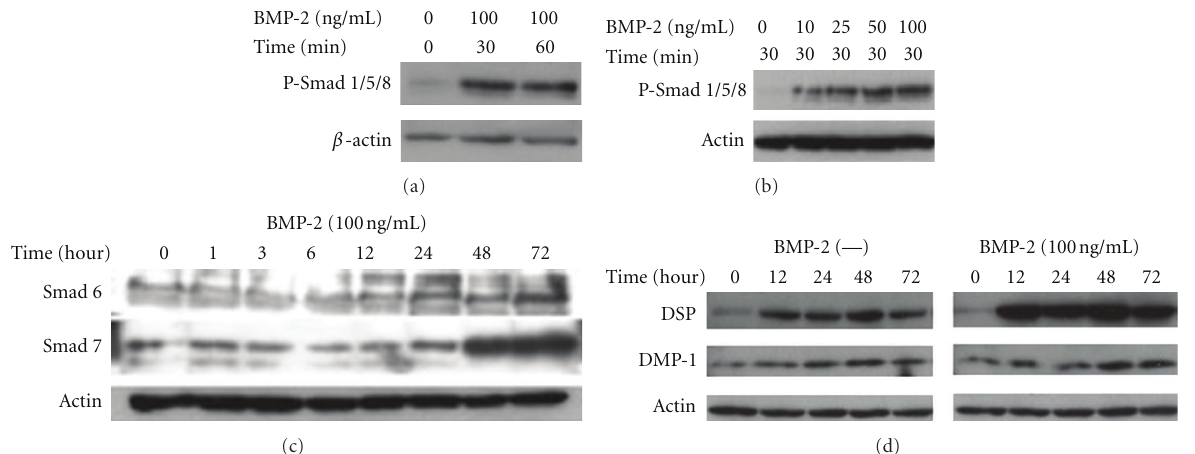
Figure 2: Western blot analysis of (a) and (b) phosphorylated Smad1/5/8, (c) inhibitory Smad6/7, and (d) DSP and DMP-1 extracted from KN-3 cells after treatment with